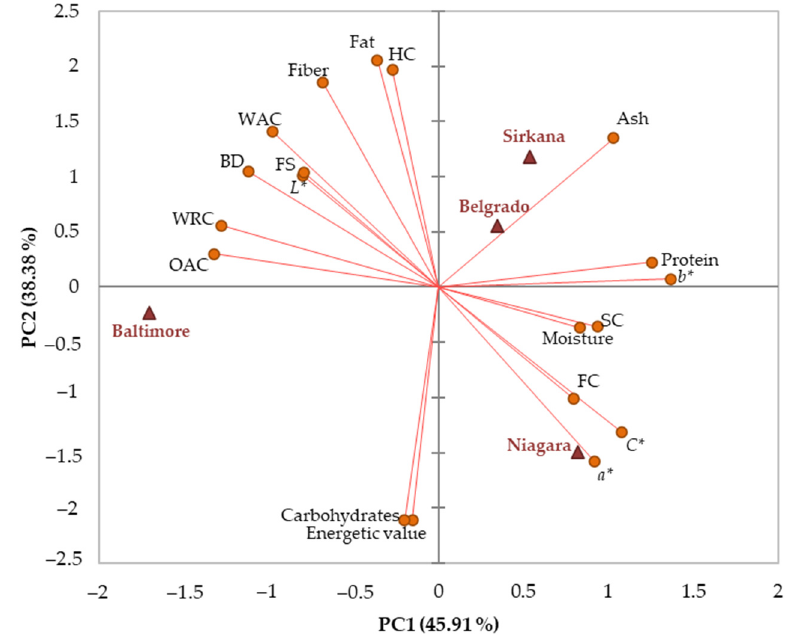
Figure 3. Principal component Analysis (PCA) bi-plot: HC—hydration capacity, WAC—water absorption capacity, WRC—water retention capacity, OAC—oil absorption capacity, FC—foaming capacity, FS—foaming stability, SC—swelling capacity, and BD—bulk density. Samples are marked with triangles and variables with bullets.